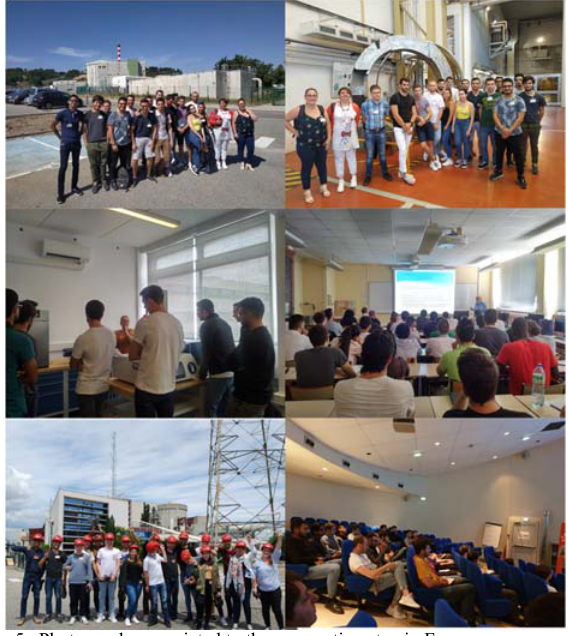
Fig. 5. Photographs associated to the preparation step in France  Different visits: a visit to Cadarache CEA Center, a